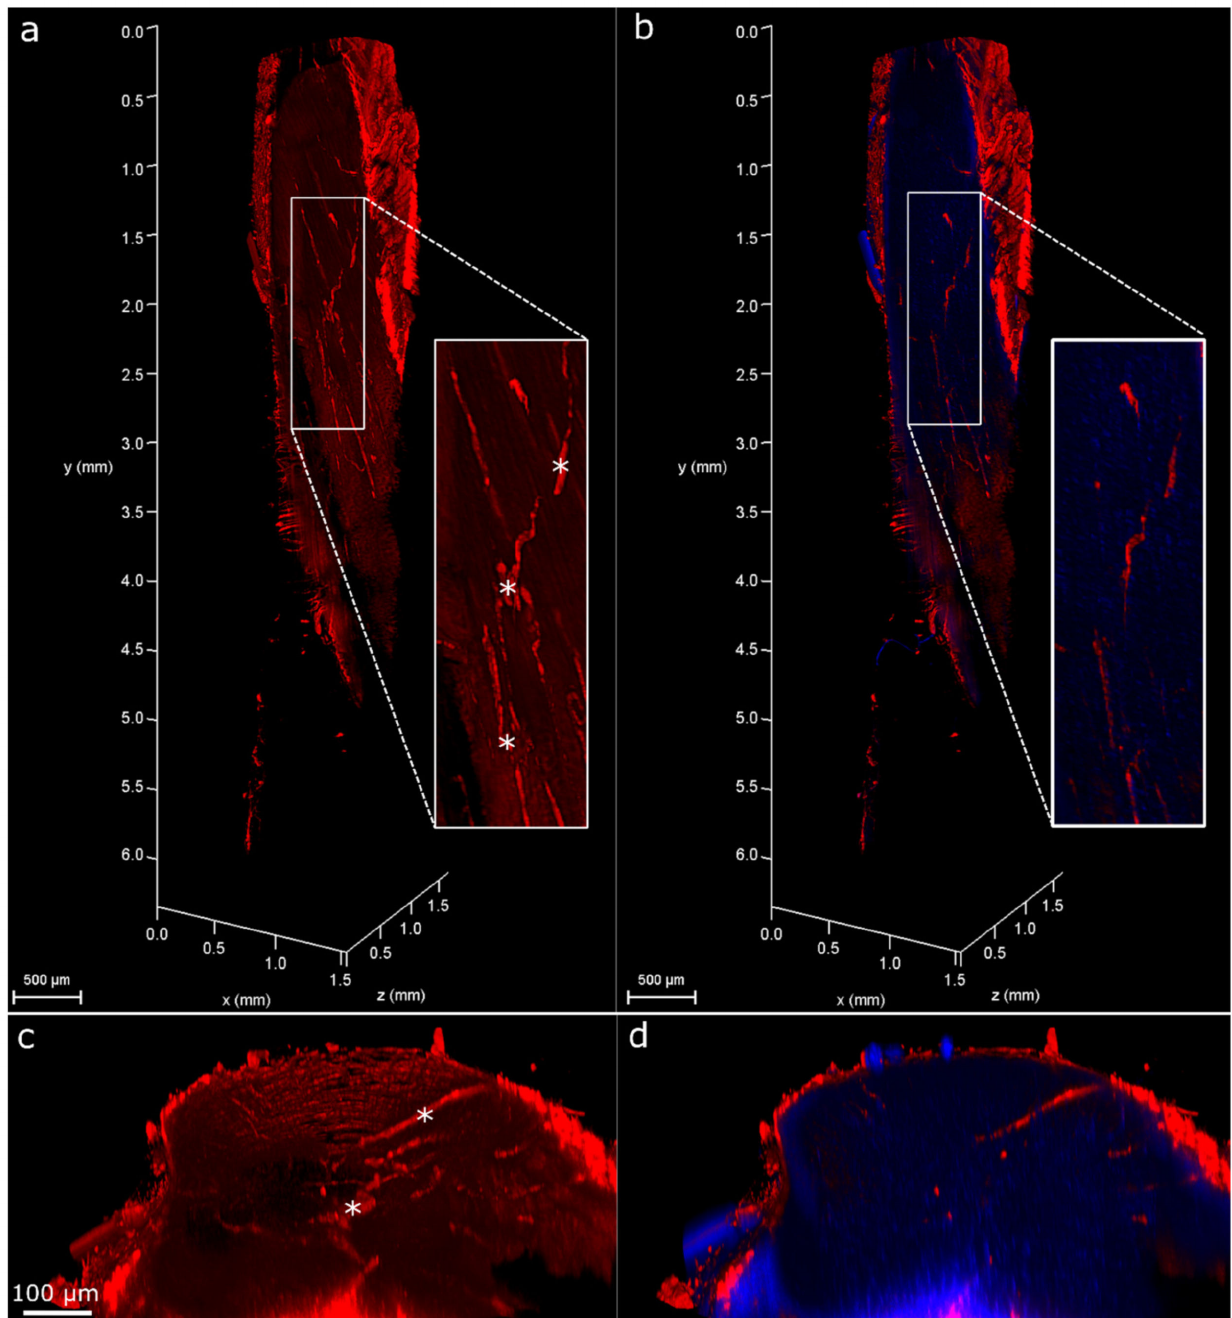
Figure 3. Three-dimensional visualisation of uninjured tendons labelled for CD146. Reconstruction of Achilles tendon labelled for CD146 (red, a , b ) and with nuclei counterstained (blue, b ). Reconstructions have been clipped longitudi- nally to allow for visualisation of CD146 within the tendon core. Inset shows magnified region. Transverse (xz) views of reconstructions ( c , d ) show a complex network of CD146 in uninjured tendon, localised to the IFM (indicated by *) and